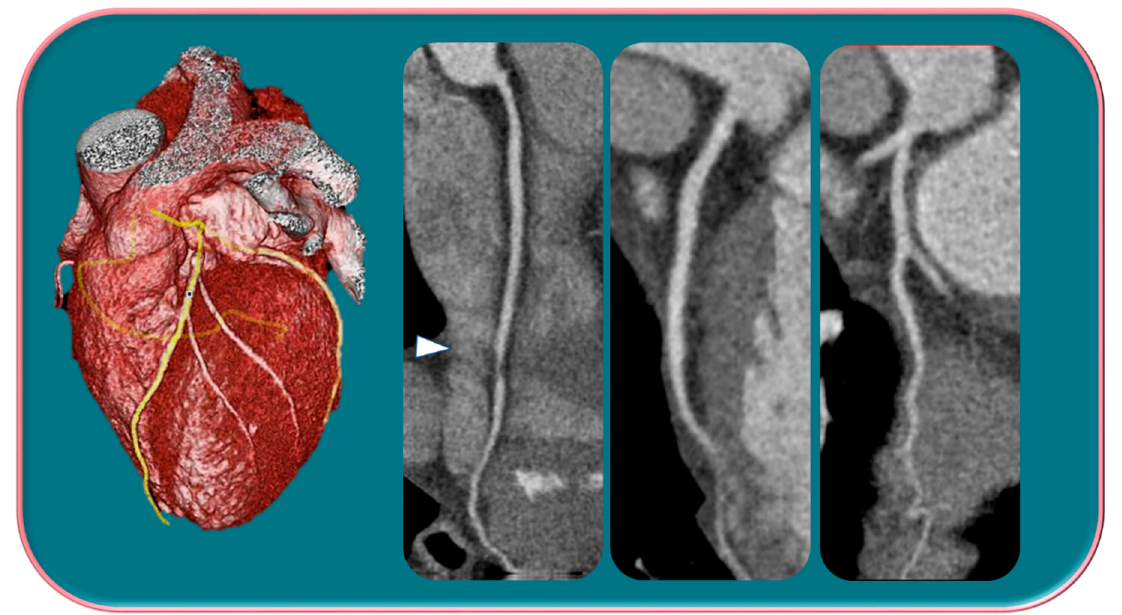
Figure 1. Male, 39-years-old, patients with history of dyslipidemia, type-1 obesity, and higher level of stress at work. The patient reported a non-anginal chest pain for which an ergometric ECG stress test was performed, and the results were negative. According to the Diamond–Forrester score, the patient was first categorized as a low pre-test probability risk of having CAD. To correctly rule-out CAD, the patients underwent CCTA examination, which showed a severe non-calcific plaque in the distal right coronary artery (white arrowhead).